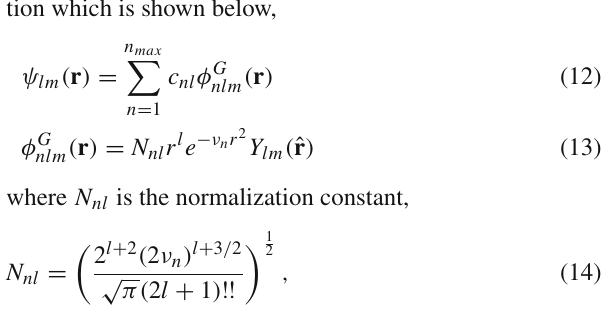
and c nl is the variational parameter, which is determined by the dynamics of the system. The Gaussian size parameters are chosen according to the following geometric progression: